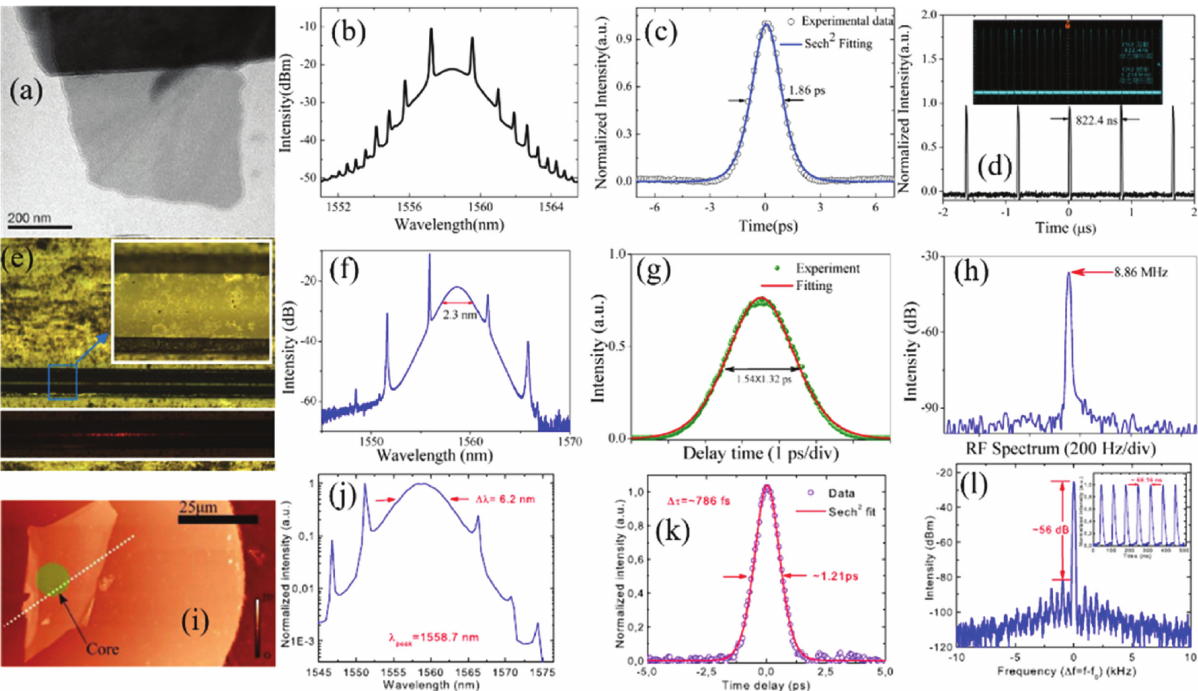
Figure 11: Mode-locked fiber lasers with various SAs at the 1.55- μ m region. (A–D) Bi Te . (A) TEM images of the Bi Te . (B) Optical spectrum. (C) Autocorrelation traces. (D) Pulse train. Reproduced with permission 2 3 2 3 from Ref. [15]. Copyright 2012, American Institute of Physics. (E–H) WS . (E) Photograph of the D-shaped fiber coated with WS 2 spectrum. (G) Autocorrelation traces. (H) RF spectrum. Reproduced with permission from Ref. [24]. Copyright 2015, Springer. (I–L) BP. (I) AFM image of transferred BP film on the fiber end. (J) Optical spectrum. (K) Autocorrelation traces. (L) RF spectrum and wide-range RF spectrum (inset). Reproduced with permission from Ref. [32]. Copyright 2015,